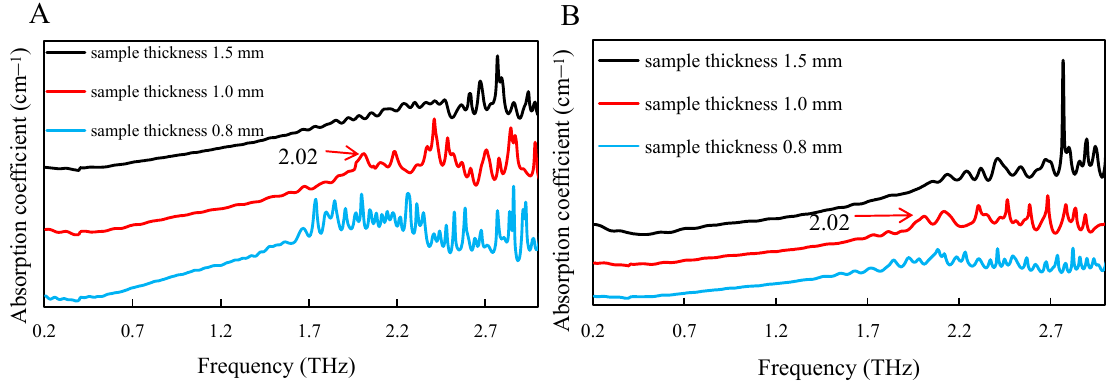
Figure 5. THz analysis of different thickness cellulose samples. ( A ) WC and ( B ) MCC. When samples were too thick, THz spectral transmittances were low, and the obtained optical absorption rates were unstable. Moreover, there was no great interference when the frequency band was below 1.7 THz, so the absorption characteristics could not be obtained. Due to the high absorption intensity of the THz spectrum, the characteristics of and polyethylene (PE) could effectively reduce the absorption